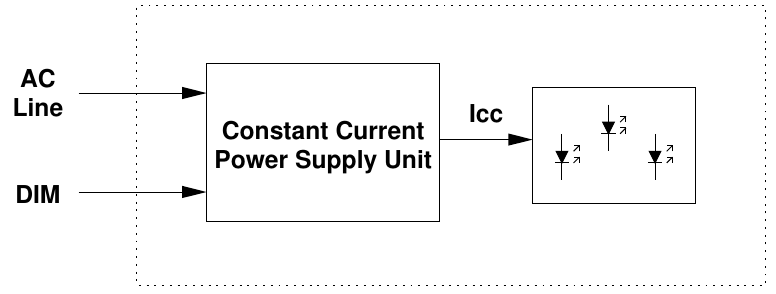
Figure 1. Standard light-emitting diode (LED) lamp.